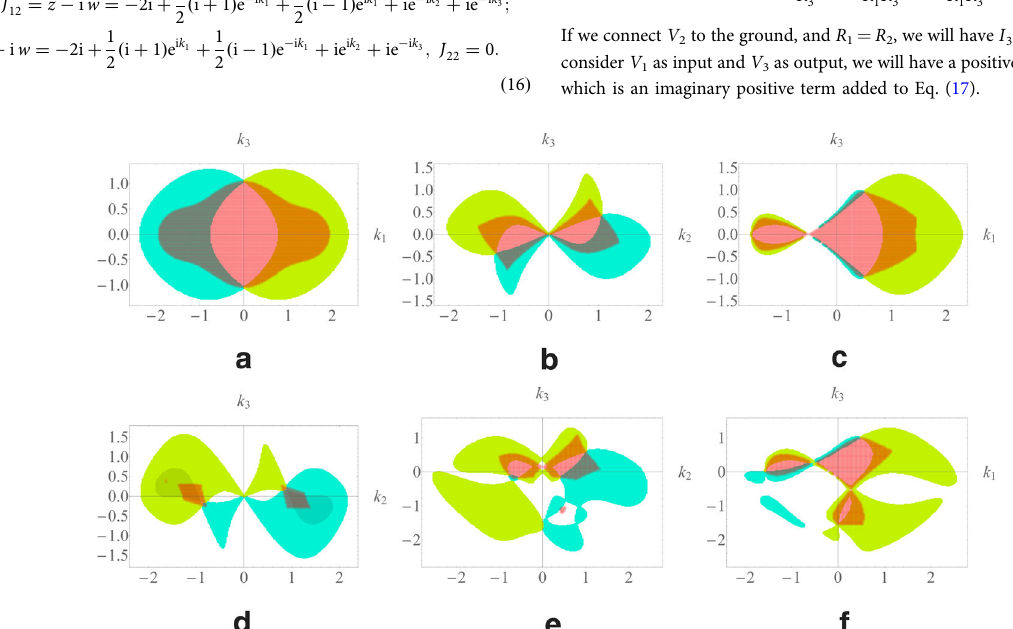
Fig. 6 Topological (tidal) regions superimposed onto regions of different vorticities. We plot the tidal regions (translucent red) superimposed onto ; (cid:2) 1 regions of different vorticities v ¼ 1 ; 1 and − 1, colored dark green, green, cyan and dark cyan respectively. The respective nodal knot metals (which are 2 2 ( p , q )-torus knots) with their surface termination normals ^ e n : ( a ) ^ e 2 Hopf-link ( p = q = 2), ( b ) ^ e 1 Trefoil ( p = 2, q = 3), ( c ) ^ e 2 Trefoil, ( d ) ^ e 1 ( p = 2, q = 5), ( e ) ^ e p = 3, q = 3) and ( f ) ^ e 1 3-link ( 2 3-link. In all cases, the tidal islands surround a region of zero vorticity (white). In ( d ), this white region is very tiny, lying at the intersection of ± 1 vorticity regions. Note that boundaries between vorticities of the same sign are ignored, since the skin states can intersect as long as 2 the vorticity does not change sign at a v = 0 point.